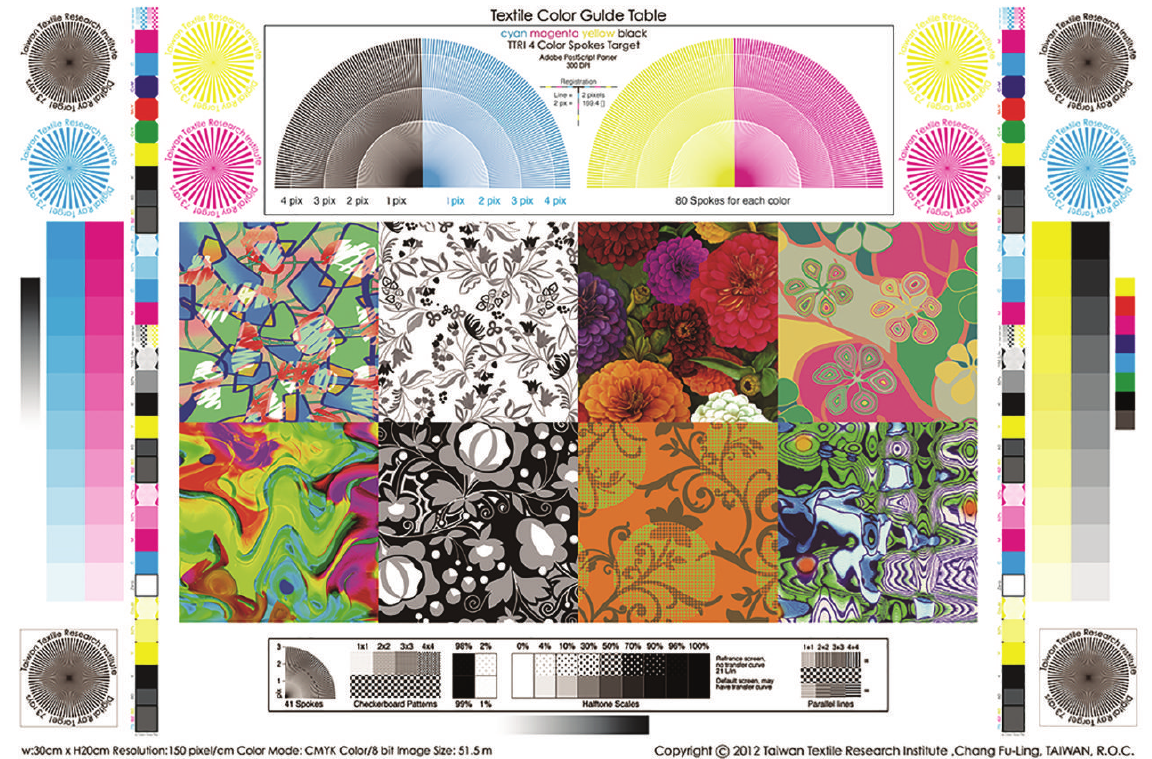
Figure 2: A color printing test form for evaluating textile images [16].